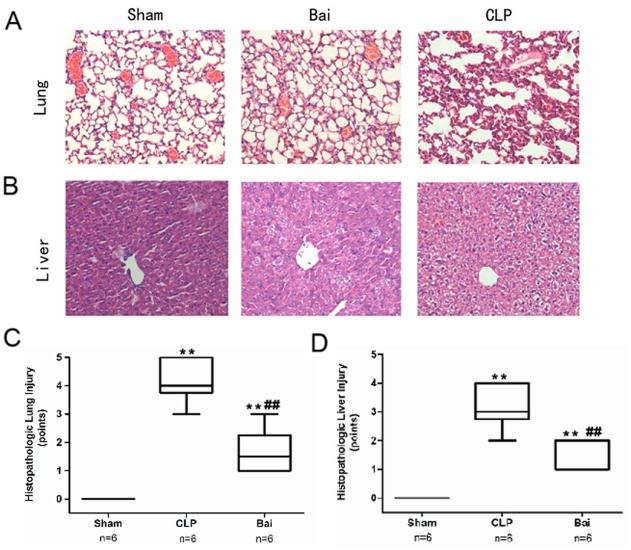
Histopathological changs of septic mice after baicalin treatment.The tissues were harvested 24 h after CLP for histopathologic examination using hematoxylin and eosin staining. Representative images from six animals per group were shown. Histopathological tests showed milder impairment in lung and liver after baicalin administration. A, After baicalin treatment, lung showed less neutrophil accumulation and alveolar destruction. B, Hepatocytes were protected and hepatic sinusoid was also preserved in baicalin treated mice. C, the severity of lung injury was scored as described in Materials and methods. D, the severity of liver injury was scored as above. ** P<0.01 vs. sham. ## P<0.01 vs. CLP. Bai, baicalin group; CLP, CLP group.